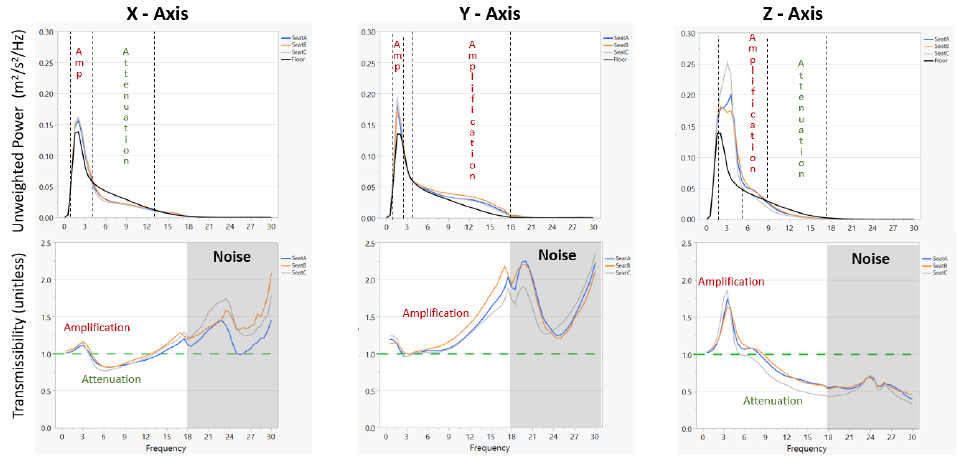
Figure 8. Unweighted power spectral densities for the x-, y- and z-axes ( top ) and Transmissibility ( bottom ) ( n = 10).